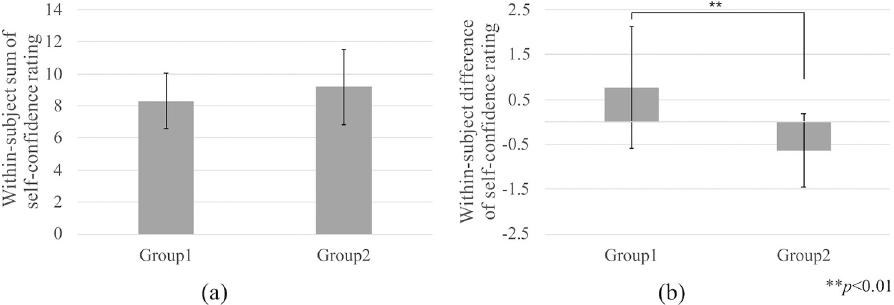
Fig 4. (a) Within-subject sum of the self-confidence ratings on Day 1 and Day 2; (b) Within-subject difference in the self-confidence ratings between Day 1 and Day 2.